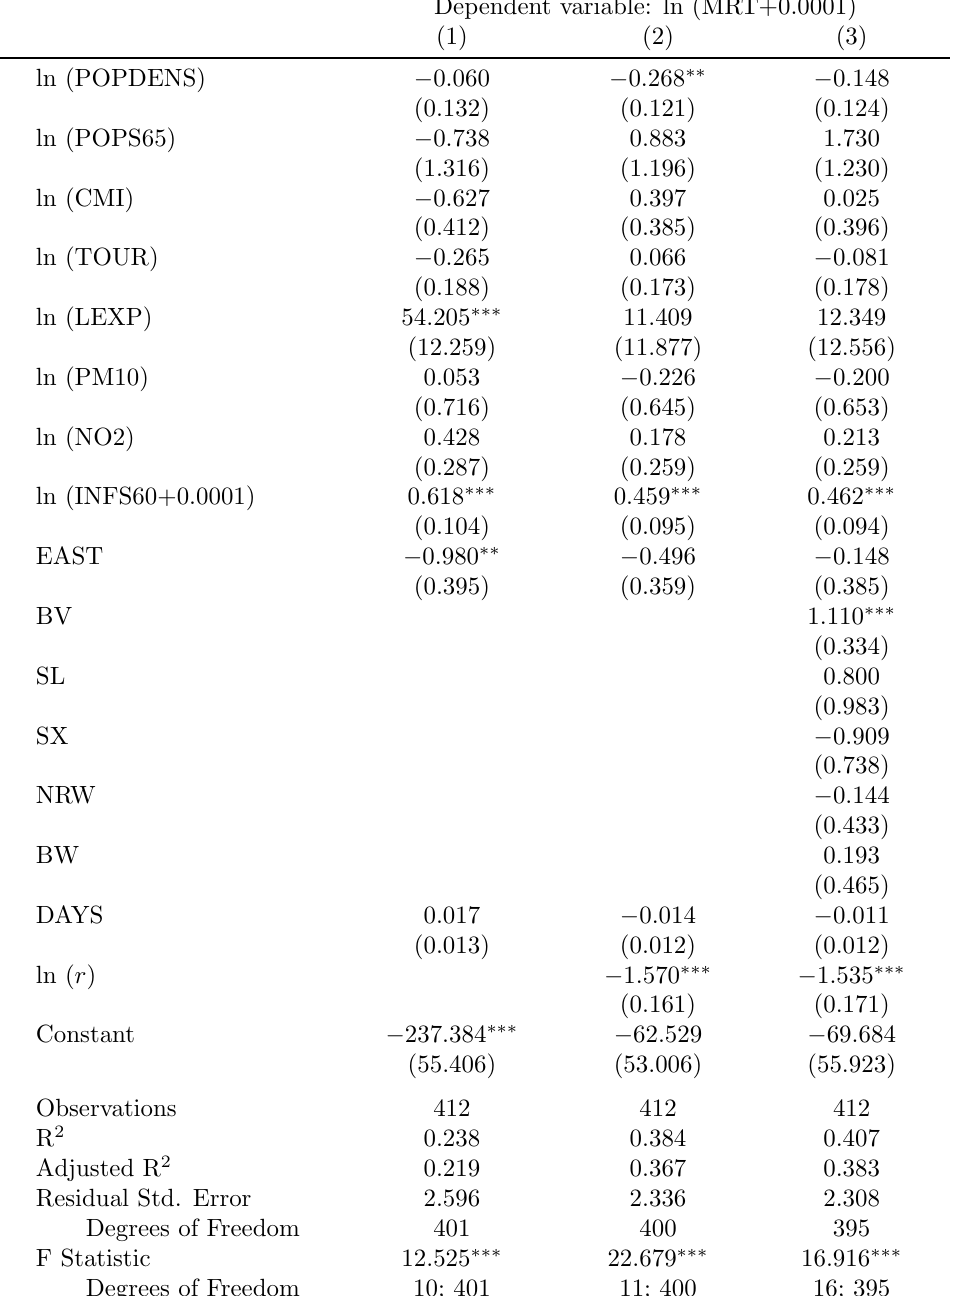
Table 8: Estimation results for the mortality model (OLS) Dependent variable: ln (MRT+0.0001)